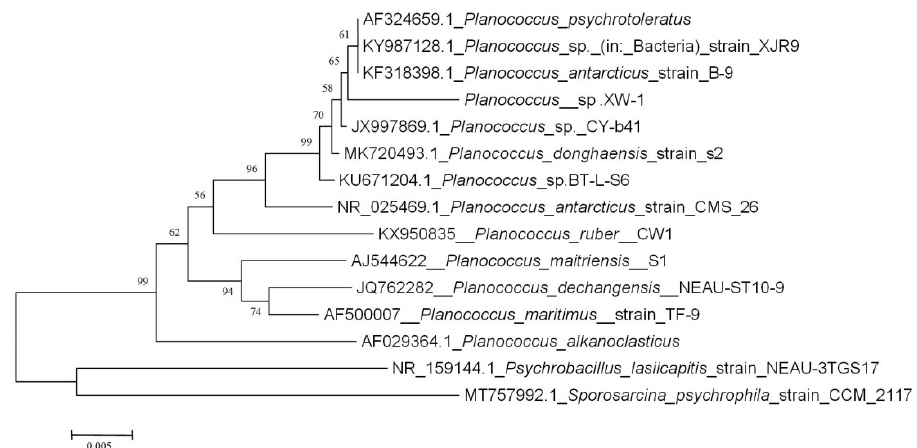
Figure 1. Scanning electron micrographs of cells of Planococcus XW-1.